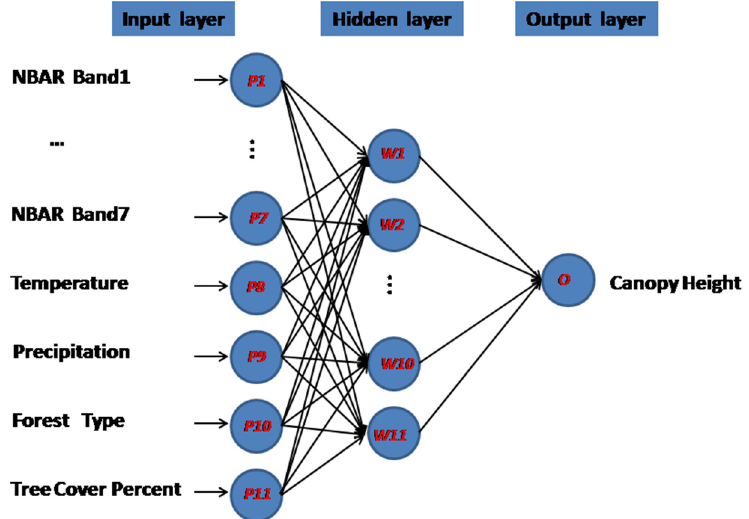
Figure 2. The schematic diagram of the ANN model proposed in this study. There are 11 neurons in the input layer, 11 neurons in the hidden layer and 1 neuron in the output